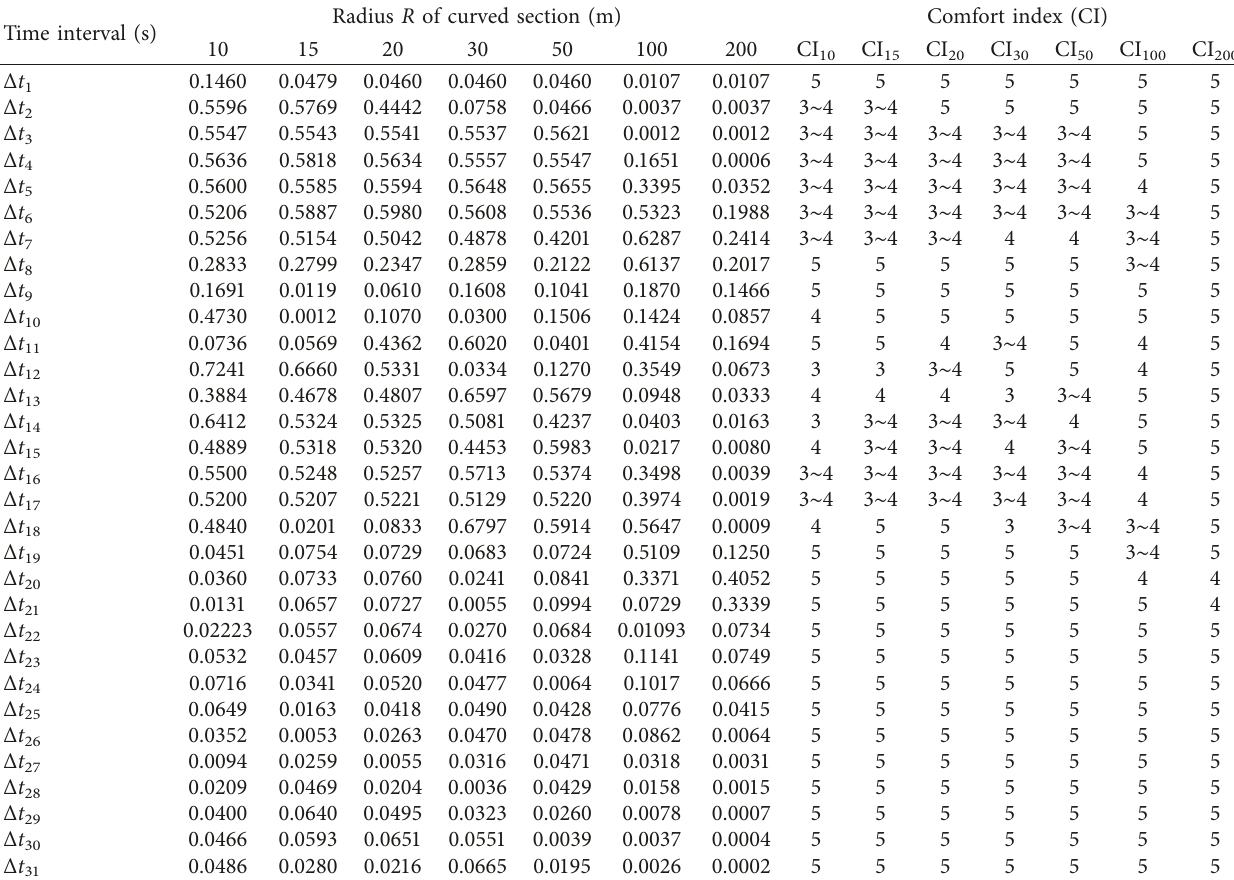
Table 6: Comfort levels with different curve radius under wet road